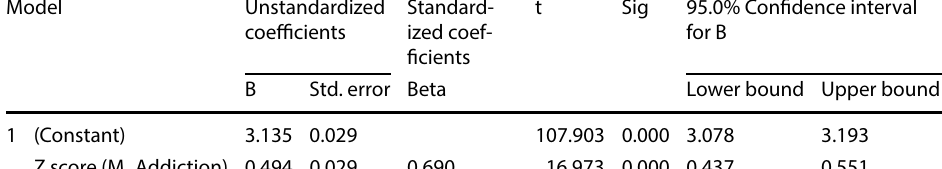
Table 5 95% confidence interval of correlation